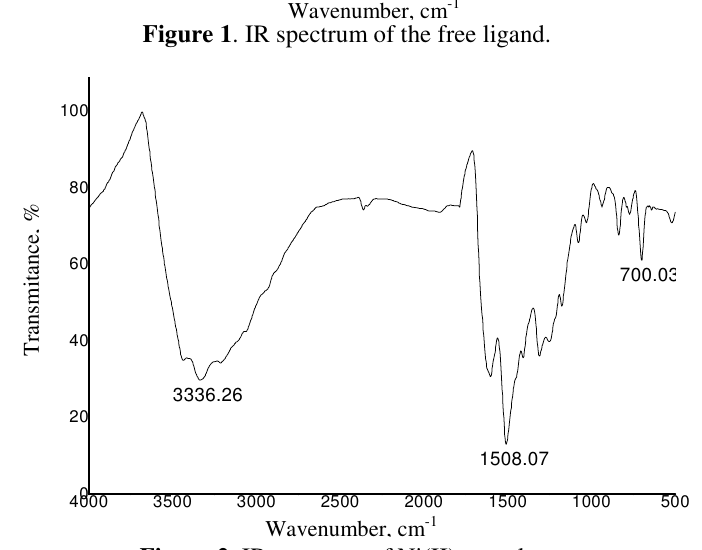
Figure 2 . IR spectrum of Ni(II)